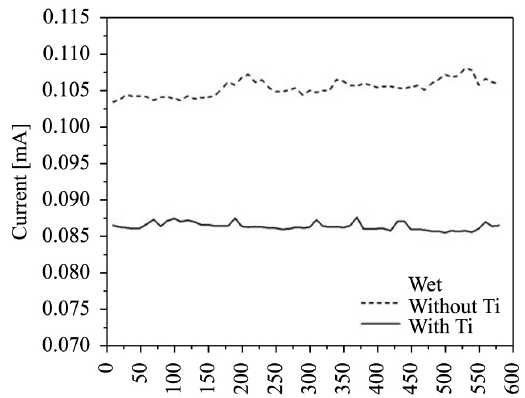
Figure 6. Comparison of the maximum leakage current obtained during the salt spray test on the insulators with and without nanometric film deposition.